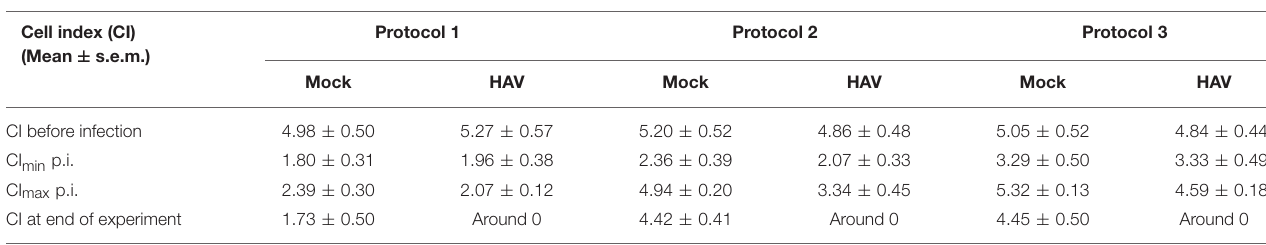
TABLE 1 | Cell Index (CI) values in FRhK-4 cells infected or not with HAV. Cell index (CI) (Mean ±